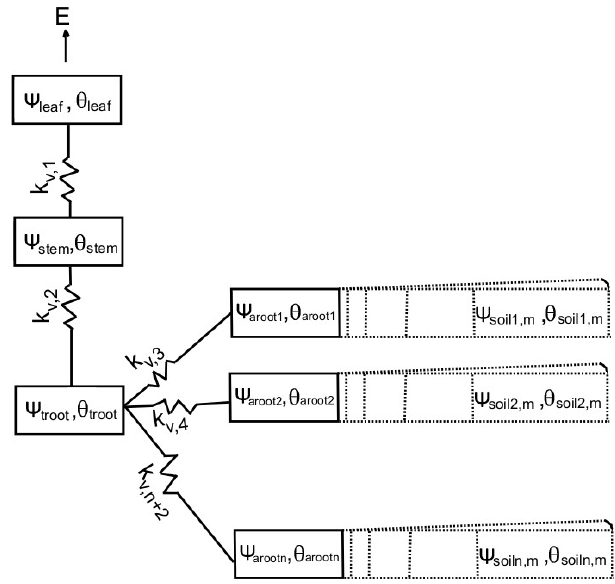
Figure 1. Schematic of FATES-hydro, with each box representing a compartment of plant tissue or soil